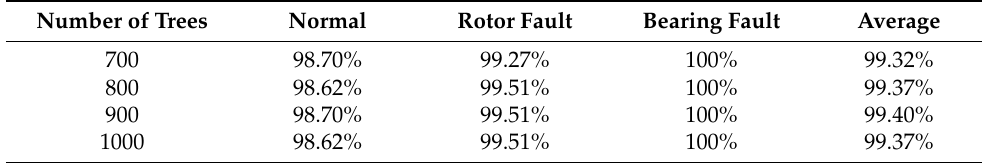
Table 9. Diagnostic accuracy of gradient boosting machine through two-fold cross-validation.